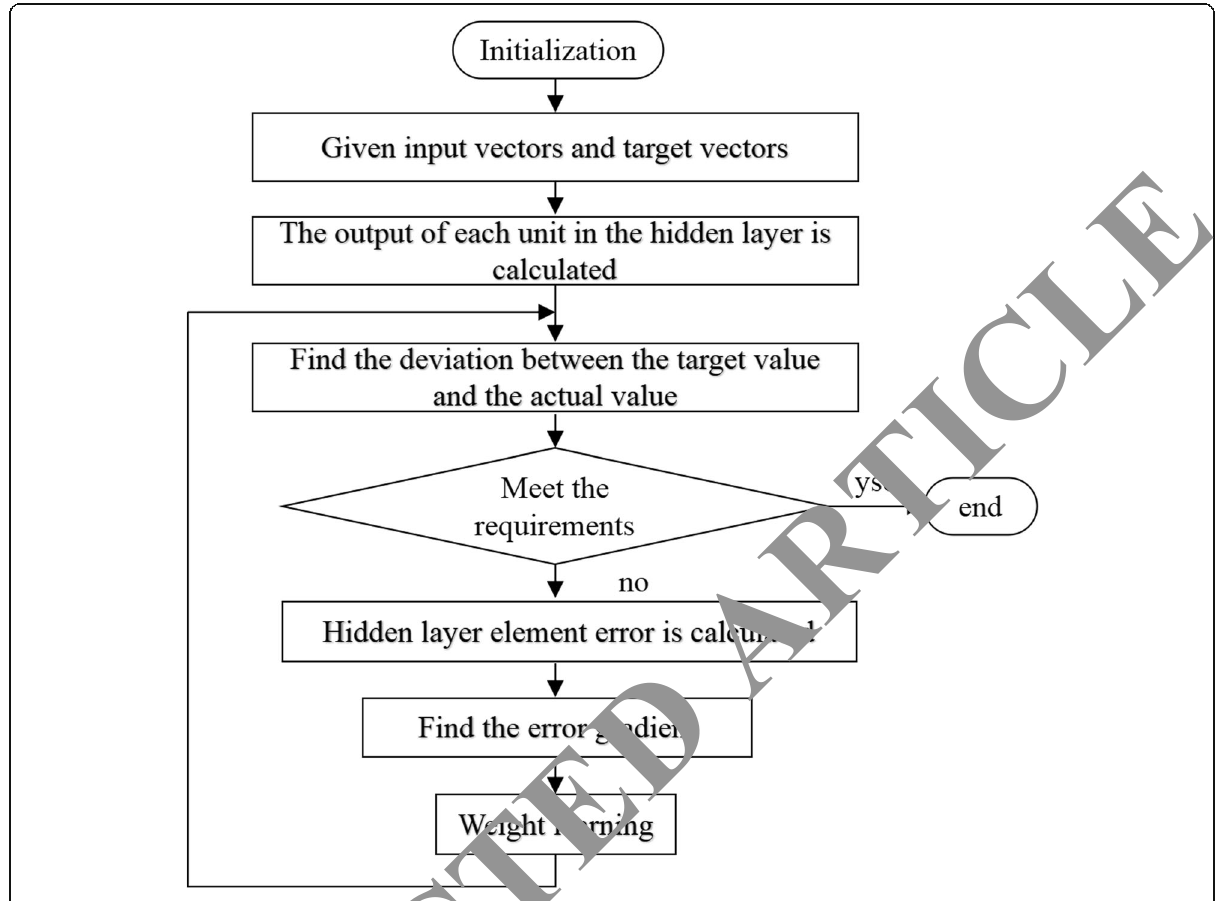
Fig. 2 BP neural network learning algorithm flow